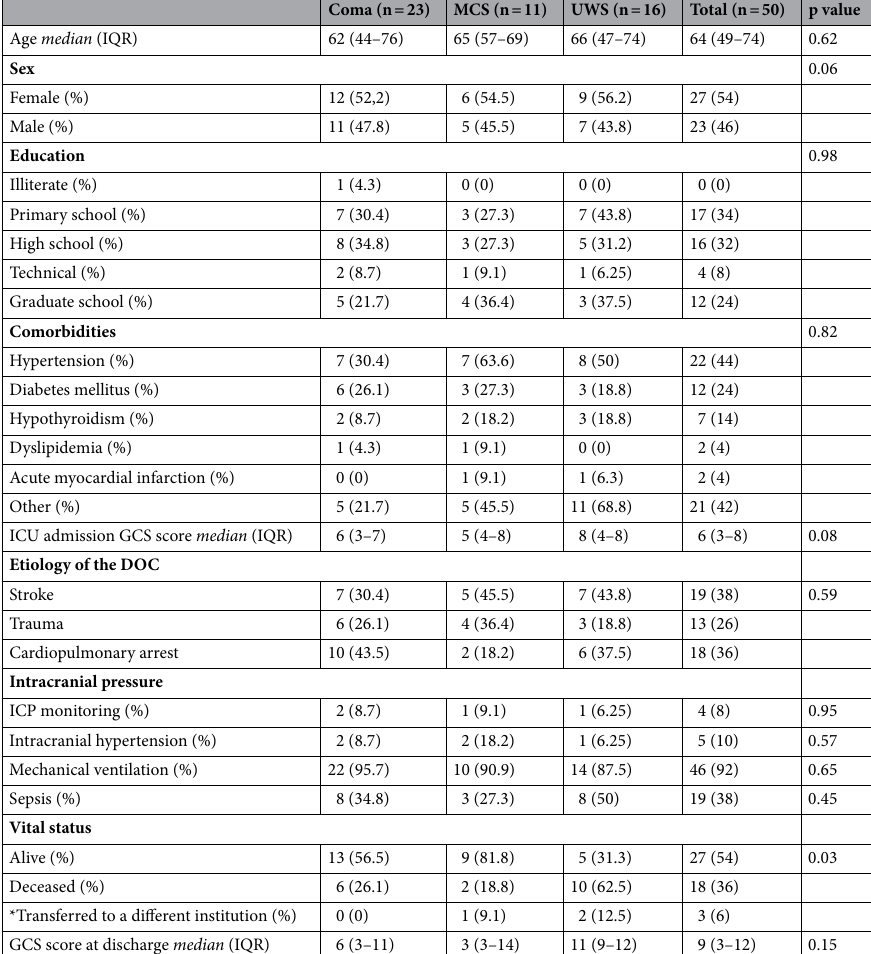
Table 1. Clinical and demographic features according to state of consciousness after ICU admission. *Expenses not covered by their health insurance company in our institution. P values correspond to comparative measures among the three patient groups.